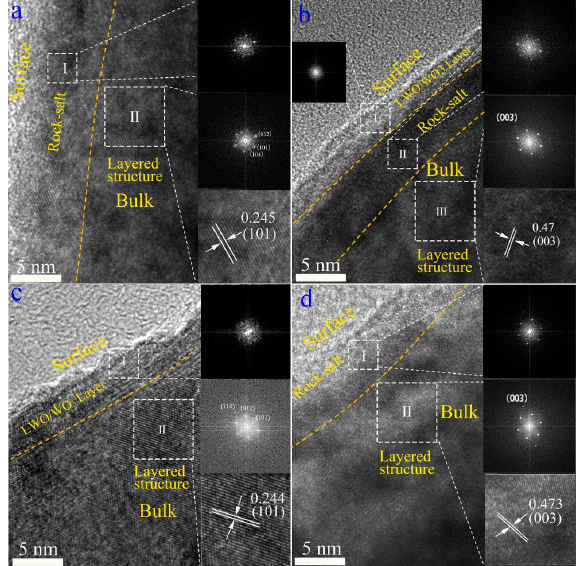
Figure 8. HRTEM images and fast Fourier transformed (FFT) images of selected areas for SC-NCM622, SC-NCM622-0.5%WO 3 , SC-NCM622-1.0%WO 3 , and SC-NCM622-1.5%WO 3 after 300 cycles. ( a ) I: Rock-salt phase, II: Layered phase; ( b ) I: LWO/WO 3 layer, II: Rock-salt phase, III: Lay- ered phase, ( c ) I: LWO/WO 3 layer, II: Layered phase, ( d ) I: Rock-salt phase, II: Layered phase.